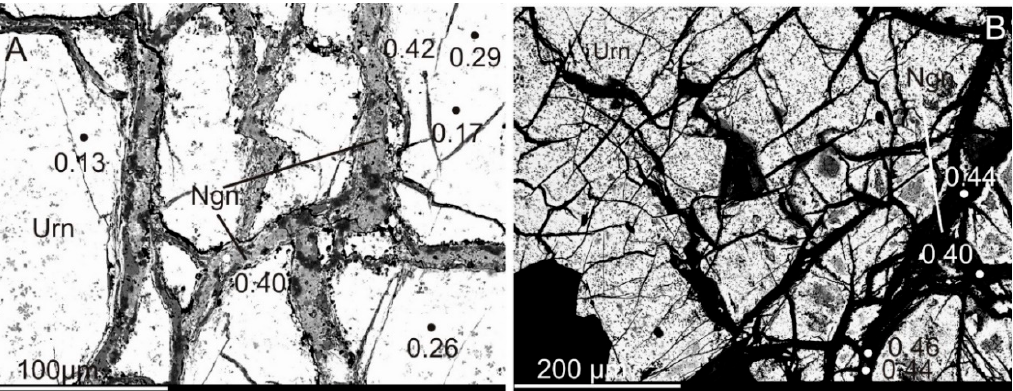
Figure 12. BSE images of uranium mineralization with distribution of Ca ( apfu , O = 4) in ningyoite and uraninite, Pot˚uˇcky uranium deposit. ( A ) Distribution of Ca in ningyoite and uraninite, ( B ) Detailed Table 3. Ranges of contents of selected components in the studied ningyoite. Locality Pot˚uˇcky (wt %) Min.